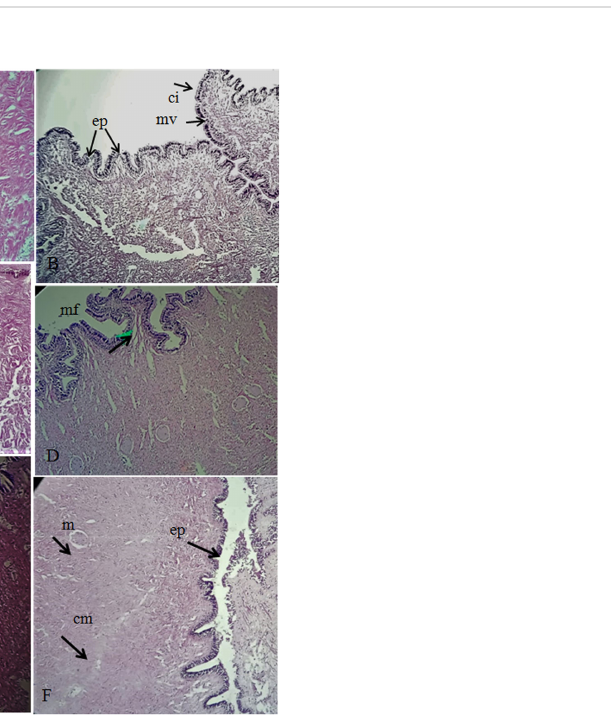
eroded epithelium and cilia (ci) formed spaces and gaps between the muscle fi bers and deformed microvilli (Figure 6E). Comparison and validation of the cellular structure of the normal foot of organisms sampled from the